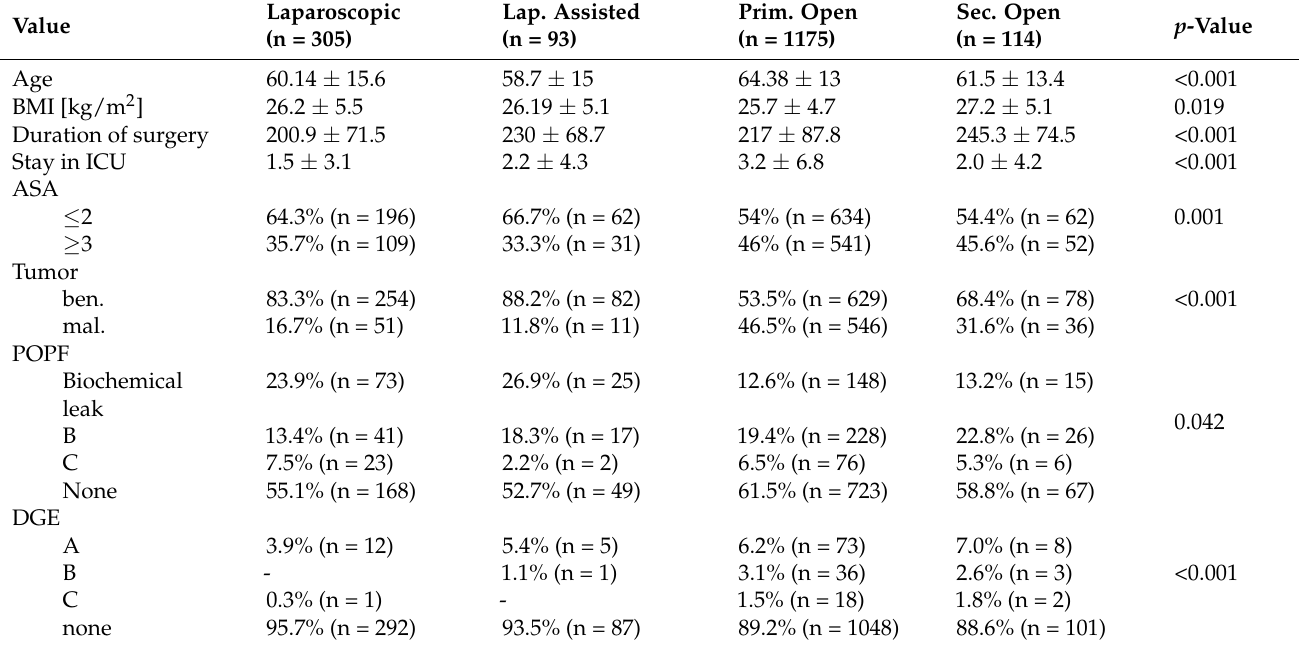
Table 2. Patients’ and surgical data apportioned by surgical technique; abbreviations: lap. Assisted, laparoscopically assisted; prim. Open, primarily open; sec. open, secondarily open; BMI, body mass index; ICU, intensive care unit; ASA, American Society of Anaesthesiologists; ben., benigne; mal., malignant; POPF, postoperative pancreatic fistula; DGE, delayed gastric emptying.